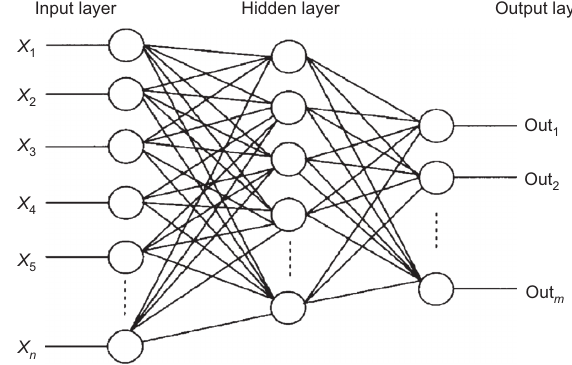
Figure 1 Schematic view of a typical MLP network with three layers based on the BP